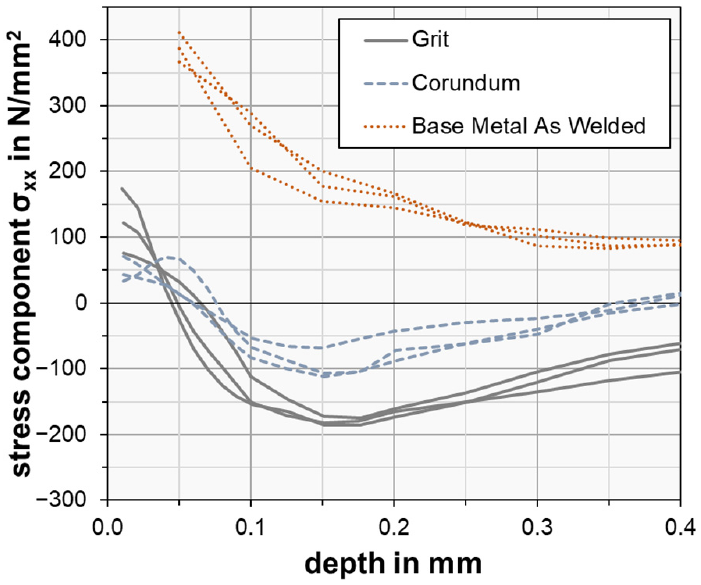
Figure 8. The residual stress measurement results of thermally sprayed specimens previously blasted with grit or corundum and non-treated reference specimens in the as-welded state at the weld toe.